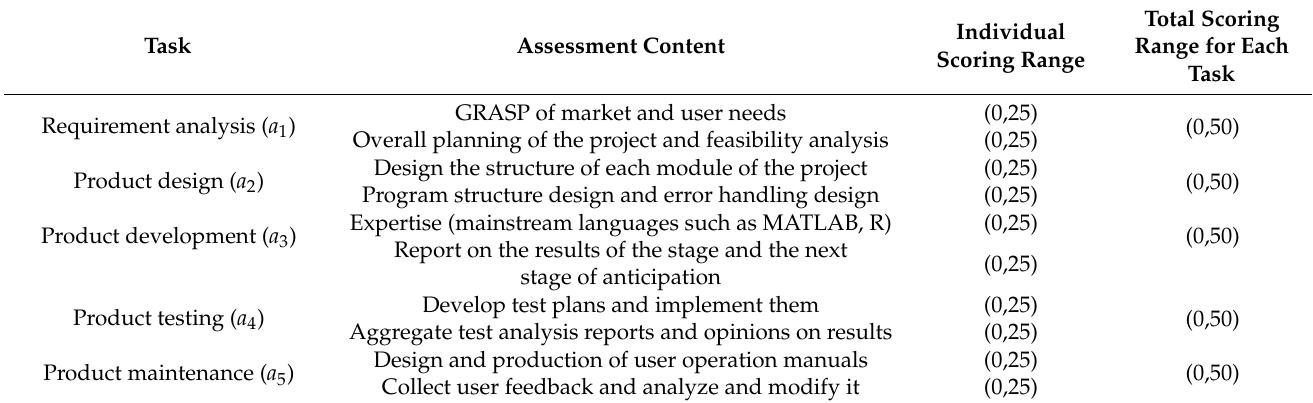
Table 1. Work ability evaluation rules.